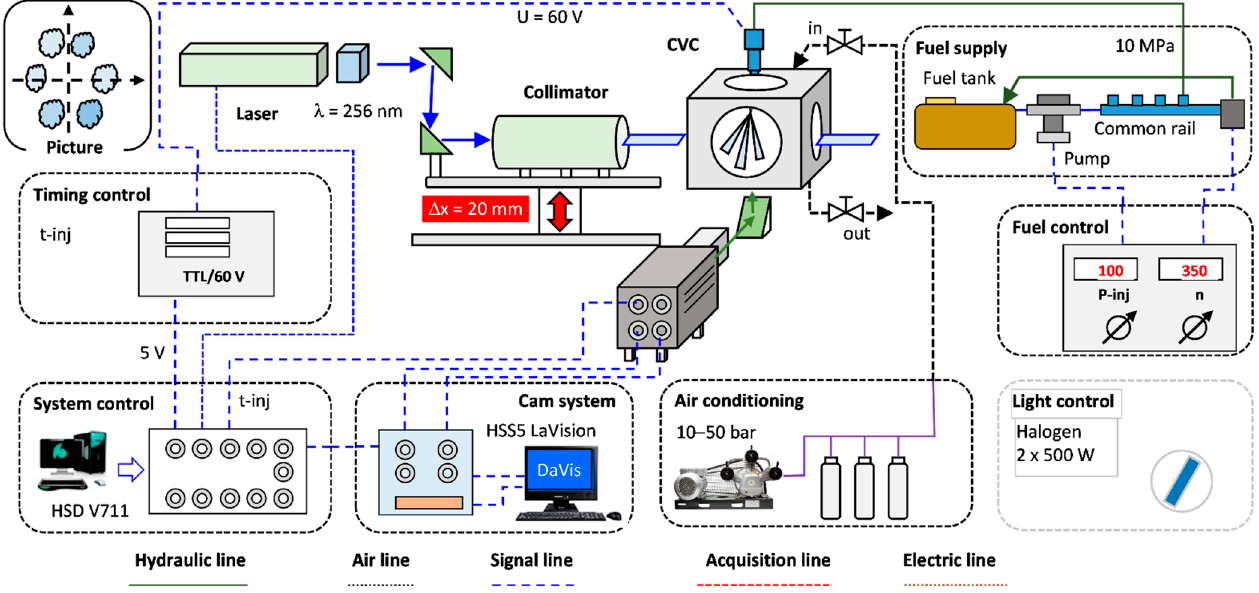
Figure 2. Schematic diagram of the structure of the fuel atomization test stand using laser illumination—cross ‐ sectional views of all fuel jets.